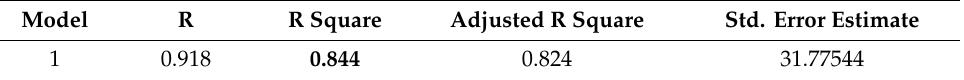
Table 7. The result of Multiple Regression Analysis for parameters from the Energy Expenditure group.